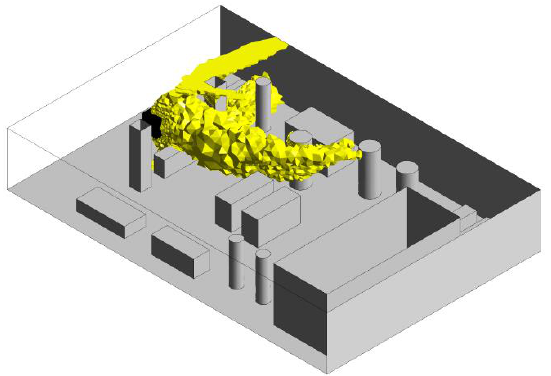
Figure 13. The 0.5LFL volume for U ref = 10 m/s. The emitting cube is shown in black. Table 4. Risk-oriented quantities obtained in the 5 dispersion